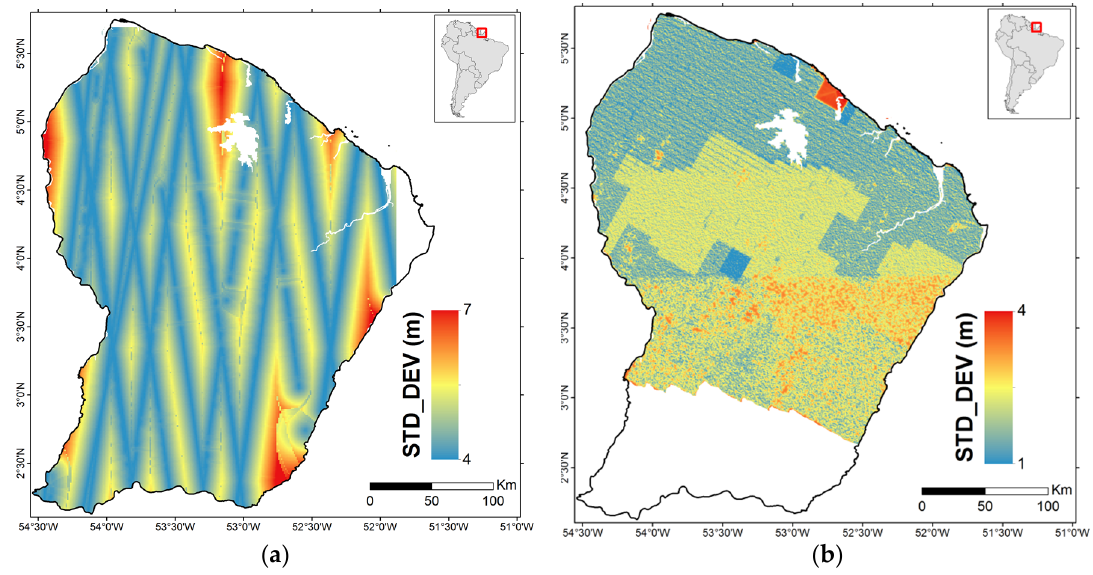
Figure 7. Wall-to-wall standard deviation map (STD_DEV) of the canopy height estimates uncertainty for: ( a ) GLAS dataset; and ( b ) LD_cal dataset.